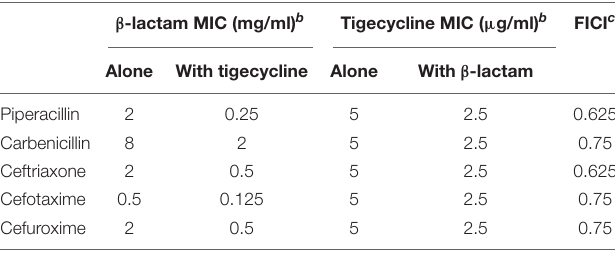
TABLE 1 | Results of checkerboard assay between tigecycline and β -lactams